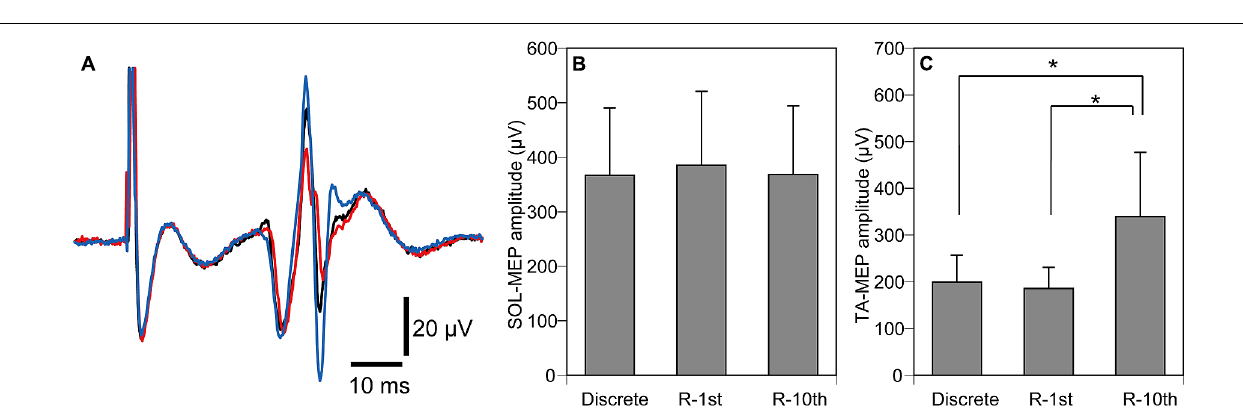
FIGURE 7 |AveragedTA-MEPs from a representative subject (A), overall average of SOL-MEP (B) andTA-MEP (C) amplitudes. The black trace indicates MEP under the discrete movement condition, the red trace indicates MEP under the R-1st condition, and the blue trace indicates MEP